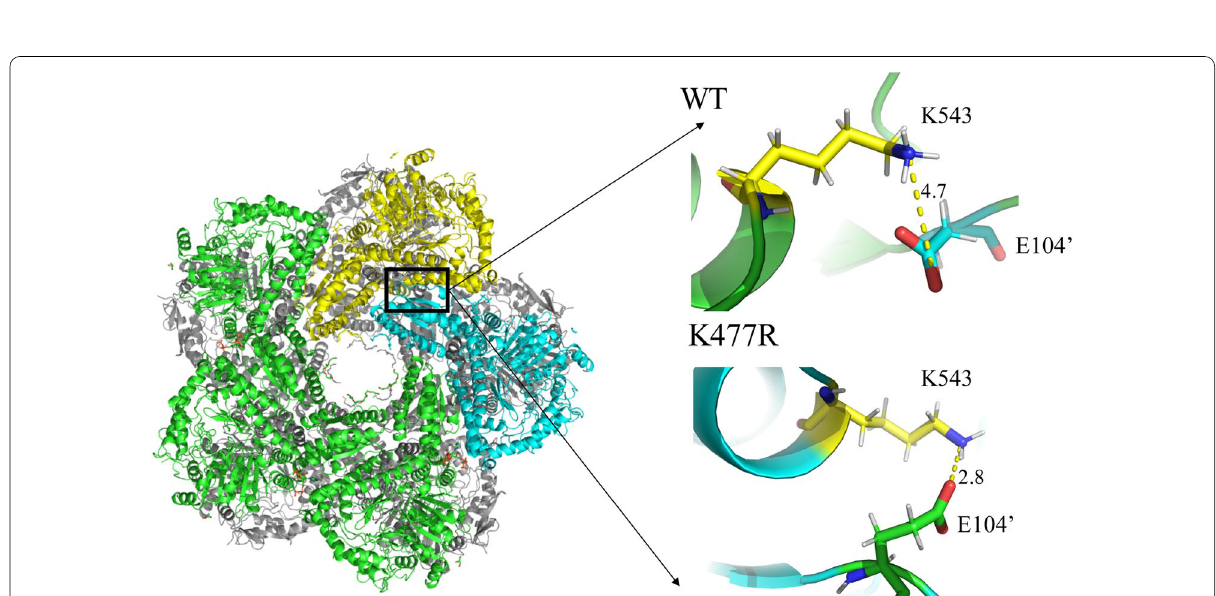
Fig. 7 Salt bridge between K543 and E104’ at the decamer interface of CadA. The minimum energy conformation was extracted by Amber cpptraj, and the distance of the interacting residues was calculated by pymol